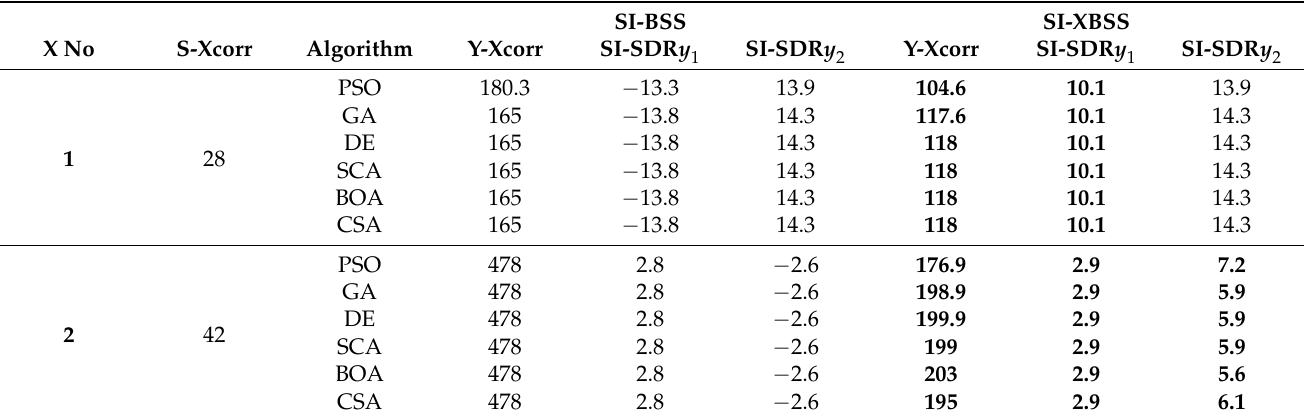
Table 5. The estimated value of SI-SDR of the two